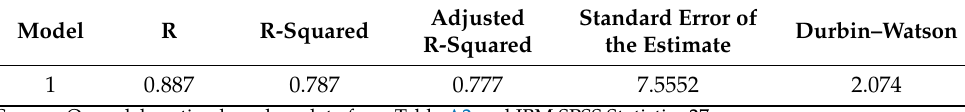
Table 2. Model summary.